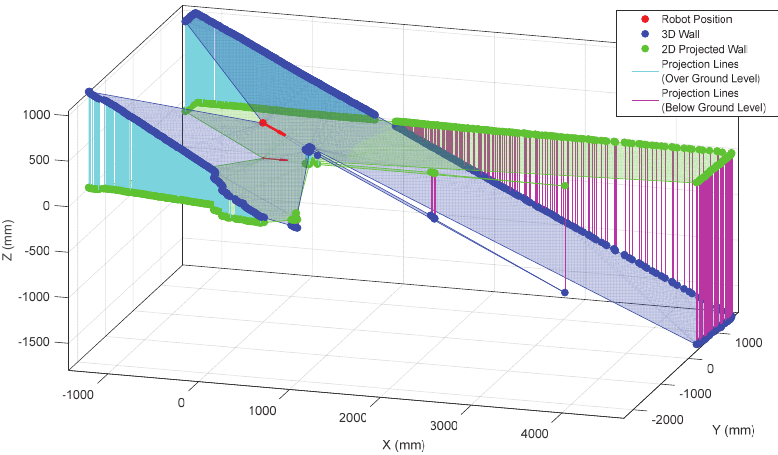
Figure 11. Original 2D scanned point cloud (blue) and its 2D projection in the horizontal plane of the reference map (green). The lines depicts the correspondence between the original and projected scan points: (light blue) cases over the ground level and (magenta) cases under the ground level.